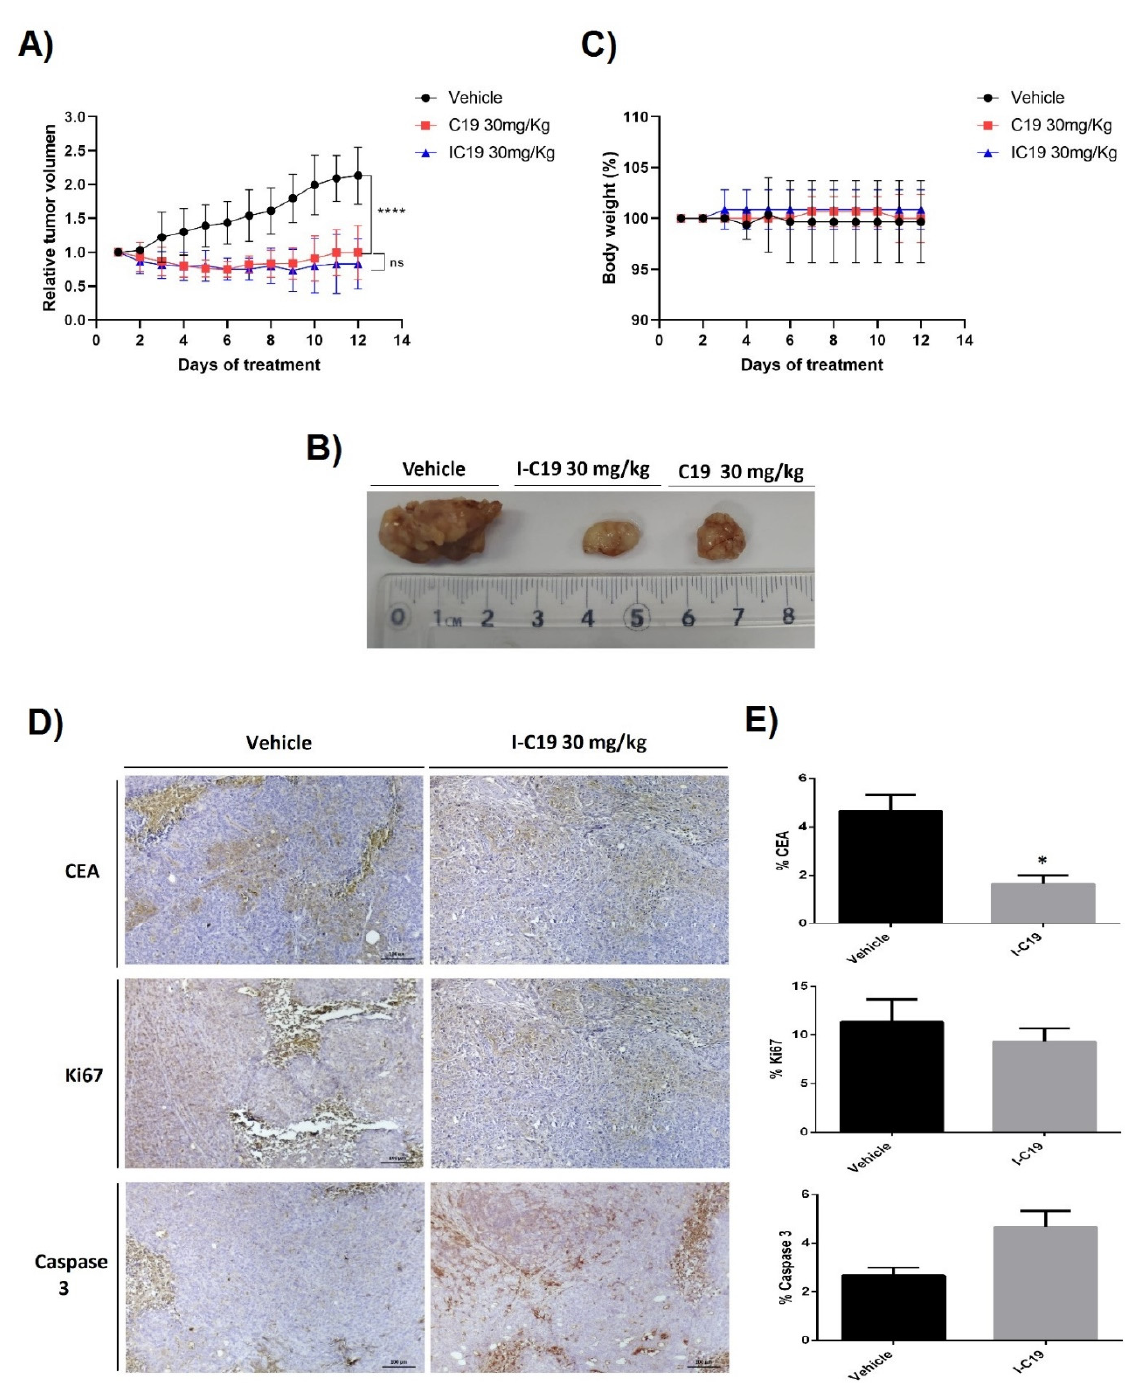
Figure 8. ( A ) I-C19 was administered every day for 12 days at a concentration of 30 mg/kg. Tumor volume was measured daily and estimated according to the formula: V =(½ d)(D 2 ); **** p < 0.001. ( B ) Representative images of tumor volume after dissection. ( C ) Body weight percentage for tumor-bearing nude mice measured every day during treatment. (D) Representative images of IHC staining for CEA, Ki67 and cleaved caspase-3 in the xenograft tumor tissues. ( E ) Graphs showing the percentage of neoplastic tissue positive to stain; * p < 0.1.